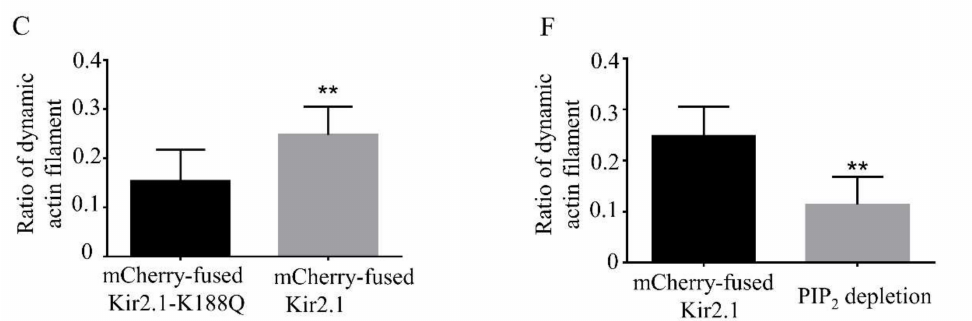
Figure 3. Mutations in Kir2.1 diminish the actin reorganization e ff ect. ( A ) The dynamics of actin filaments in Kir2.1-overexpressed cells imaged by SIM. Hela cells were transfected with lifeact-EGFP and mCherry-fused Kir2.1. Scale bar: 5 µ m. ( B ) The dynamics of actin filaments in the Kir2.1-K188Q-overexpressed cells imaged by SIM. Hela cells were transfected with lifeact-EGFP and mCherry-fused Kir2.1-K188Q. Scale bar: 5 µ m. ( C ) Quantification of the dynamic actin filament ratio. Representative images were shown in ( A ) and ( B ). n = 3–4 cells. Values are mean ± SEM. ** p < 0.01. ( D ) The dynamics of actin filaments in Kir2.1-overexpressed cells before PIP 2 depletion. Hela cells were transfected with lifeact-EGFP and mCherry-fused Kir2.1. Scale bar: 5 µ m. ( E ) The dynamics of actin filaments in Kir2.1-overexpressed cell after PIP 2 depletion. PLC agonist (10 µ M m-3M3FBS) and PI3K inhibitor (100 nM wortmanin) were used as PIP 2 depletion agents. Hela cells were transfected with lifeact-EGFP and mCherry-fused Kir2.1. Scale bar: 5 µ m. ( F ) Quantification of the ratio of dynamic actin filaments in Kir2.1-overexpressed cells before and after PIP 2 depletion. Representative images were shown in ( D ) and ( E ). n = 3 cells. Values are mean ± SEM. ** p <